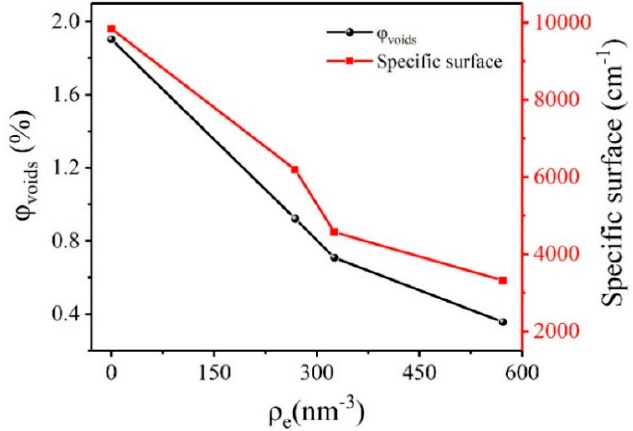
Figure 4. Scattering invariant Q of CL-20-1 crystal in different electron density matching solution.